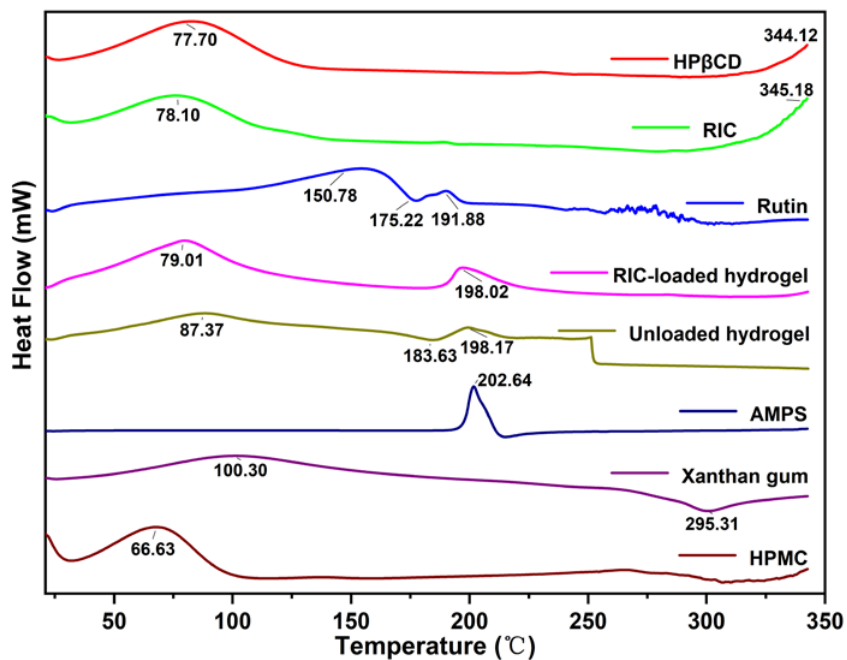
Figure 4. DSC analysis of rutin, HP- β CD, XG, HPMC, RIC , AMPS, unloaded and RIC -loaded hy- drogels.